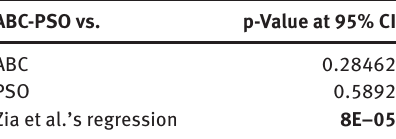
Table 7: Wilcoxon Test for ABC-PSO Algorithm. ABC-PSO vs.